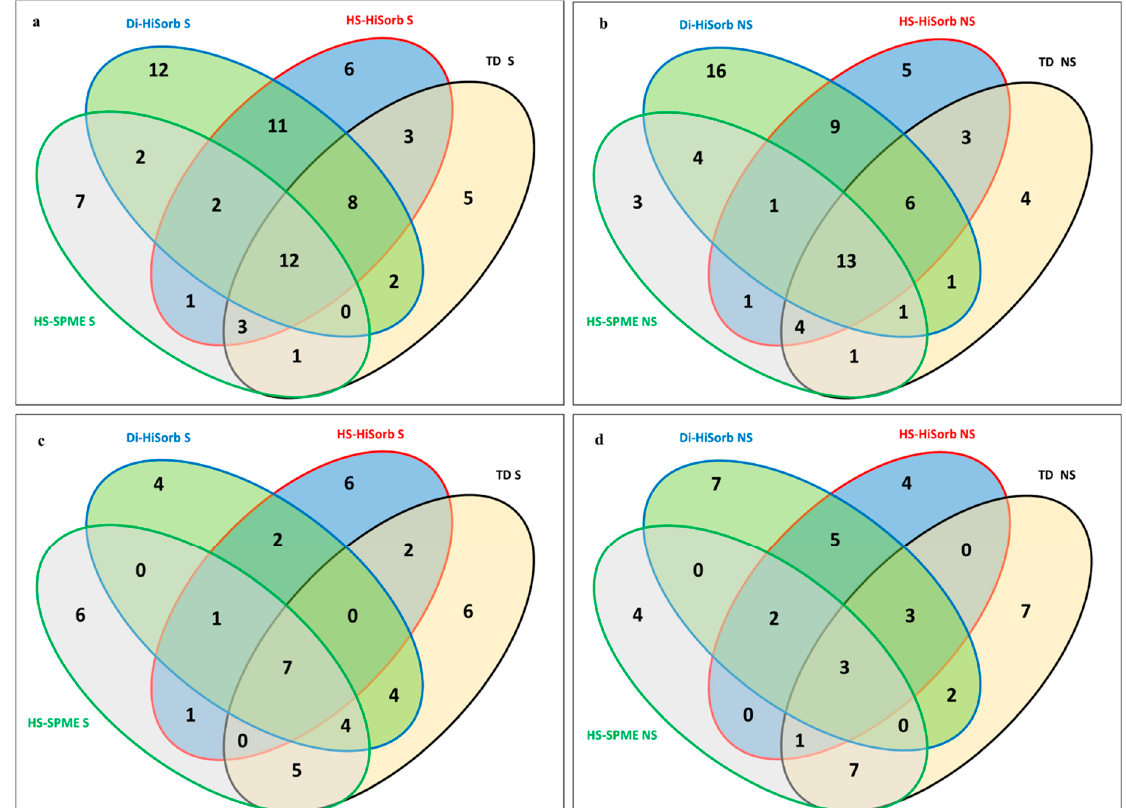
Figure 3. Venn diagrams of the number of volatile organic compounds extracted by each technique, including commonalities ( a ) with salting out using the non-polar GC column, ( b ) without salting out using the non-polar GC column, ( c ) with salting out using the polar GC column, and ( d ) without salting out using the polar GC column. Direct Immersion HiSorb without salting out (DI-HiSorb NS), Direct Immersion HiSorb with salting out (DI-HiSorb S), Headspace HiSorb without salting out (HS-HiSorb NS), Headspace HiSorb with salting out (HS-HiSorb S), Thermal Desorption without salting out (TD-NS), Thermal Desorption with salting out (TD S), Headspace Solid Phase Microextraction without salting out (HS-SPME NS), Headspace Solid Phase Microextraction with salting out (HS-SPME